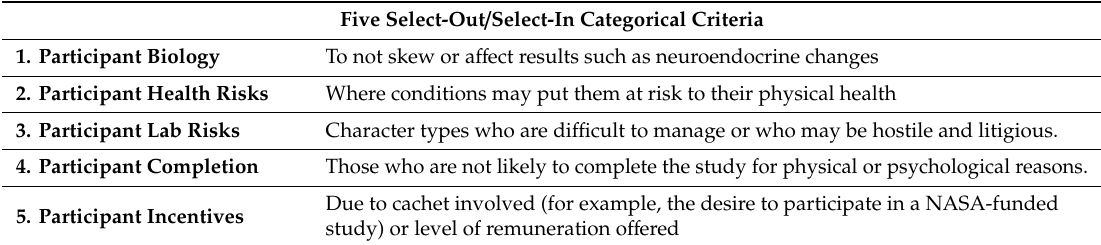
Table 2. Five Select-Out / Select-In categorical